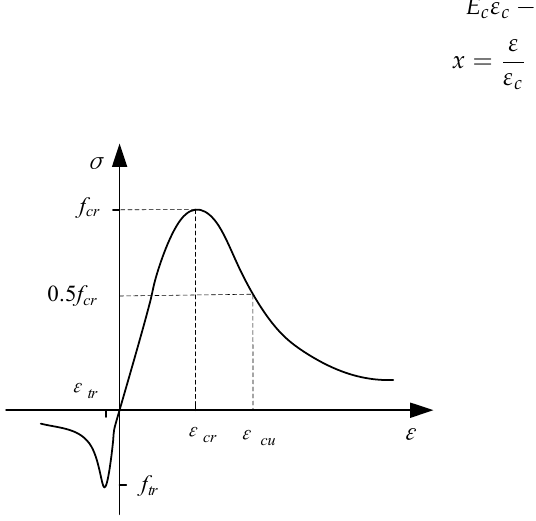
Figure 4. Concrete constitutive model, where f cr and f tr are the concrete uniaxial compressive and tensile strength, respectively, and ε is the strain value of concrete corresponding to strength.